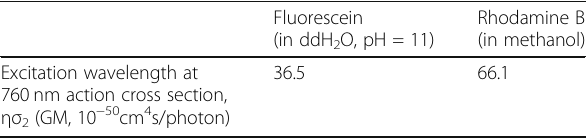
Table 1 Two-photon action cross sections of fluorescein (in